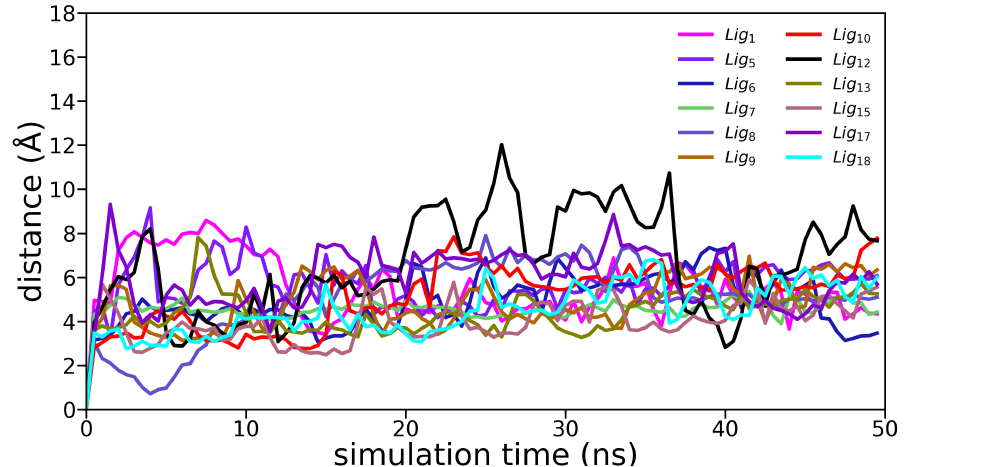
Figure A3. COM distance between the ligands staying within a reasonable COM distance to the binding site during the complex